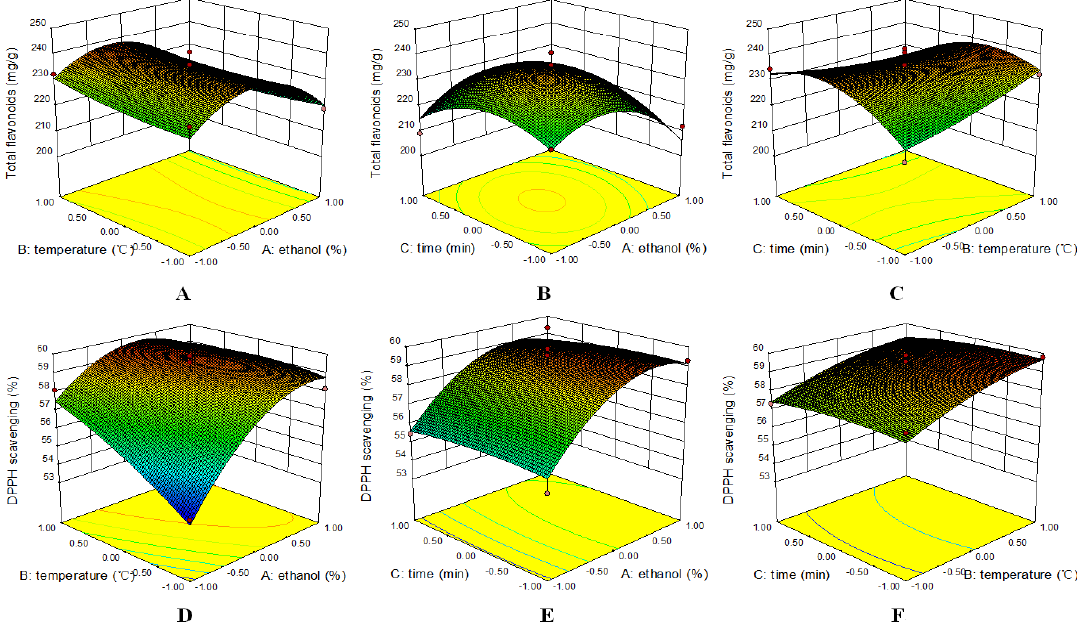
Figure 2. Response surface plots of ethanol concentration, extraction time, and temperature on the total flavonoids ( A – C ) and DPPH scavenging ( D – F ).